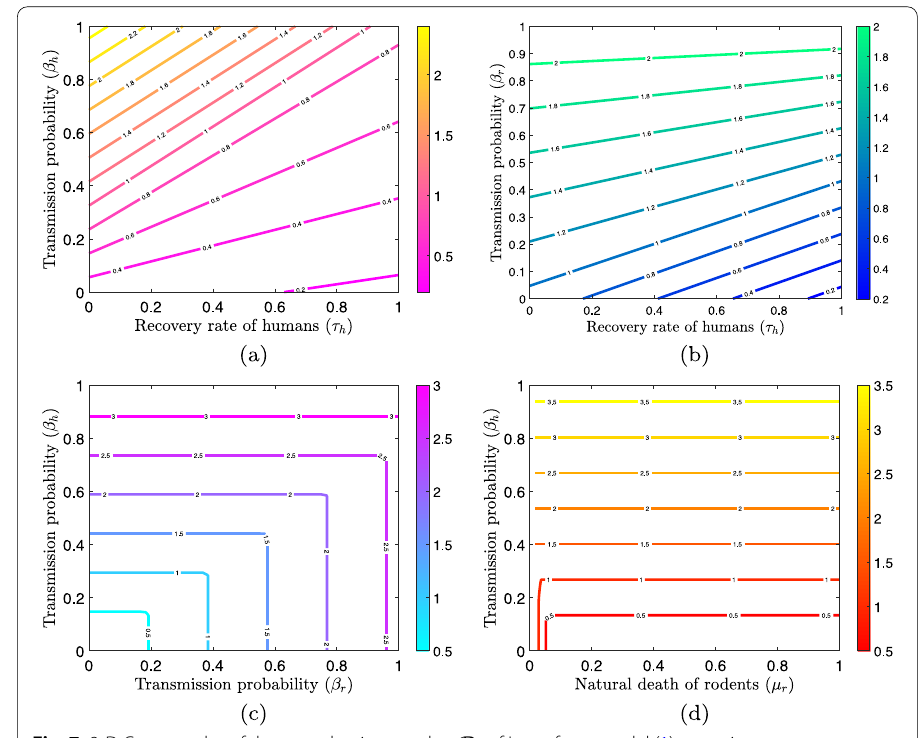
Fig. 7 2-D Contour plot of the reproduction number R 0 of Lassa fever model (1), a varying recovery rate of humans with respect to transmission probability from human-to-human. b varying recovery rate of humans with respect to transmission probability from rodent-to-rodent. c transmission probability from rodent-to-rodent with respect to transmission probability from human-to-human. d natural death of rodents with respect to transmission probability from rodent-to-rodent. The parameter values used are as given in Table 2 except for δ h = 0.2911 and µ r = 0.3840 , so that R 0 = 0.43 <